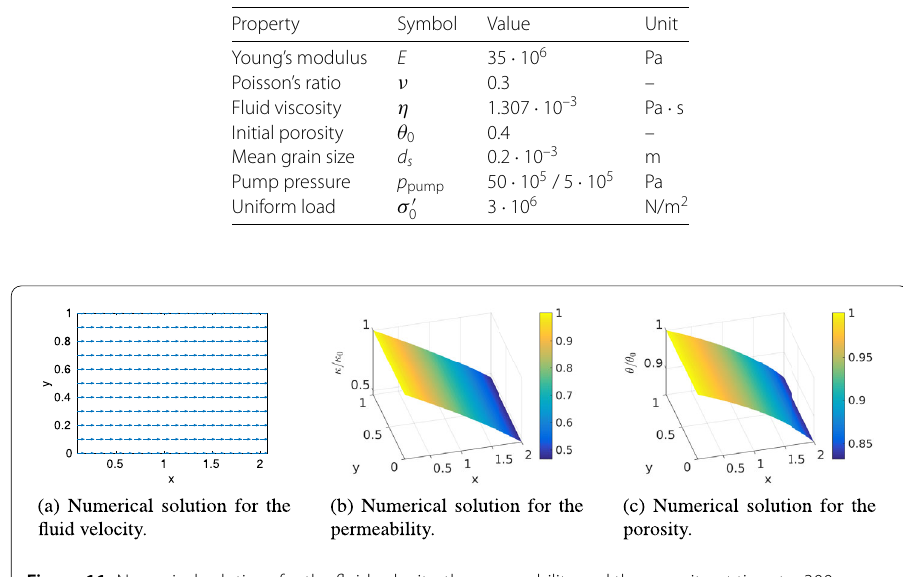
Figure 11 Numerical solutions for the fluid velocity, the permeability and the porosity, at time t = 300, obtained using the Kozeny–Carman relation